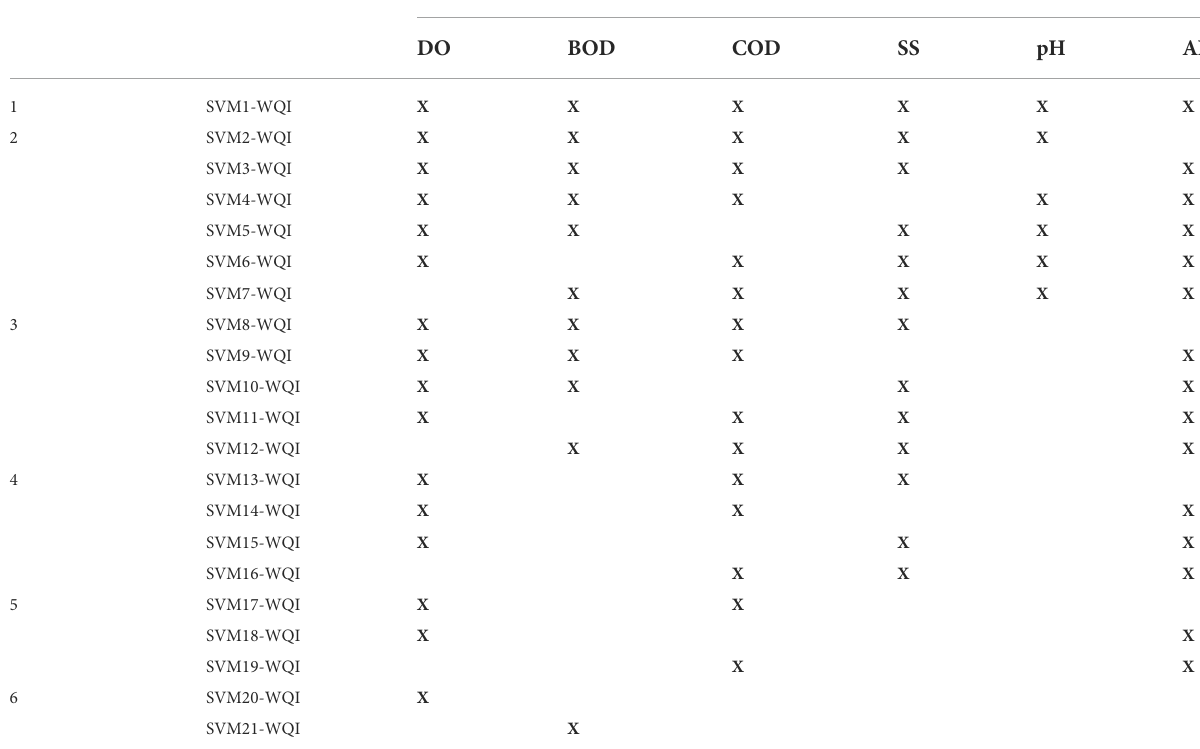
TABLE 2 Input combination data for each scenario in sensitivity analysis, with the considered parameter is marked with “ X ” . Scenario